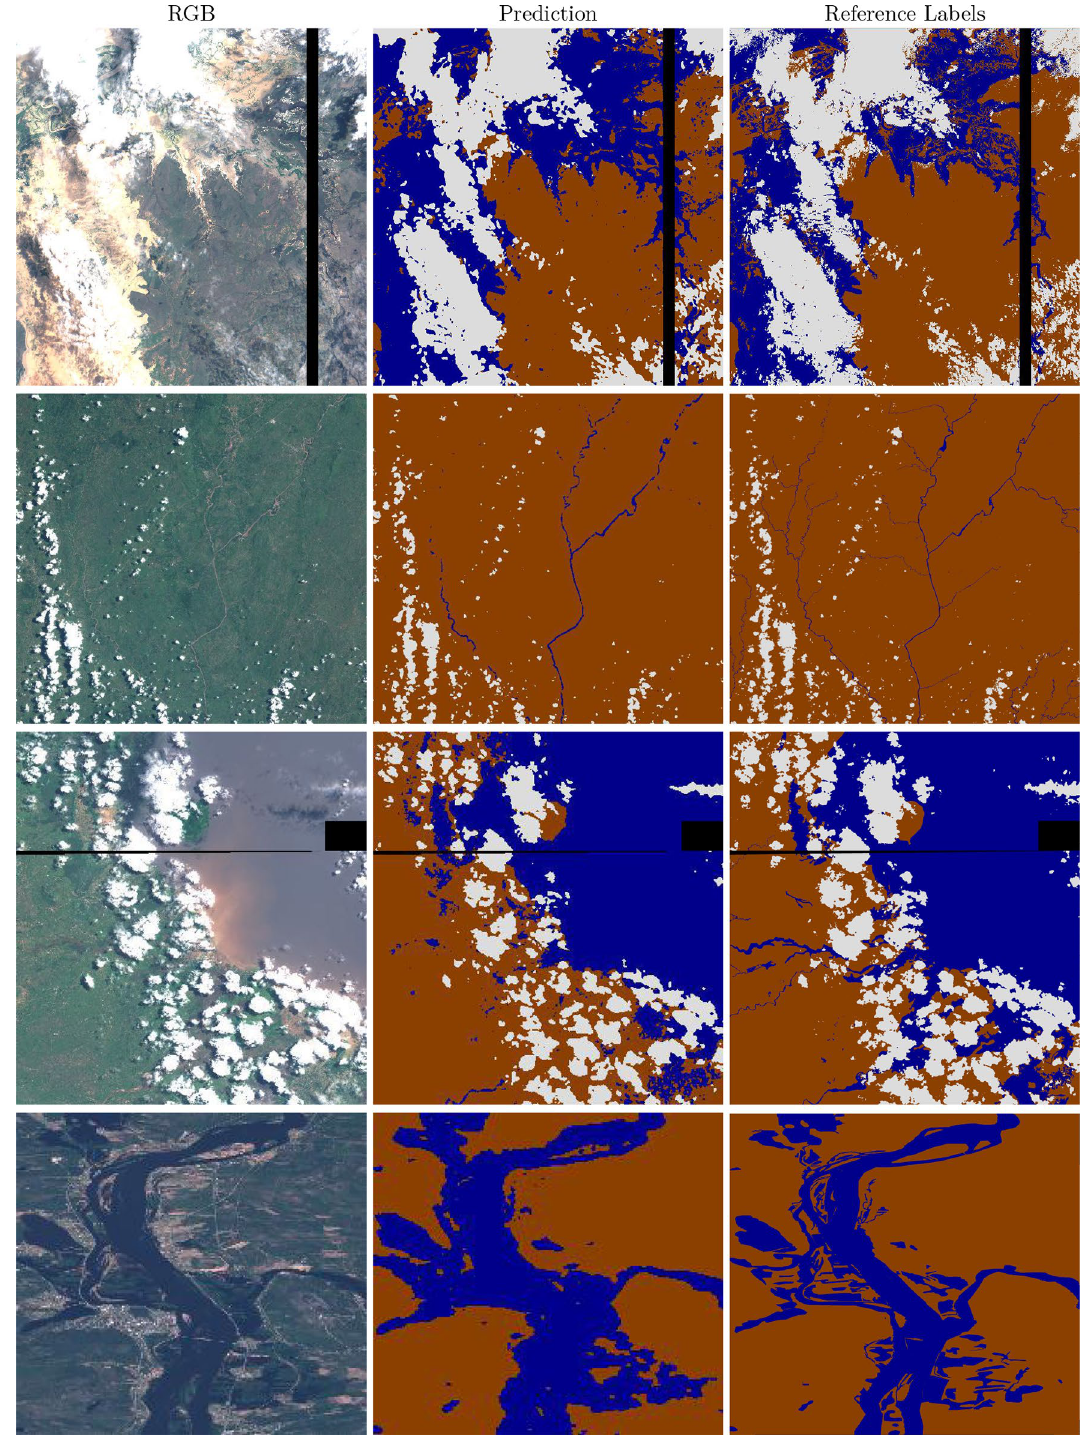
Figure 9. Segmentation results of degraded models (SCNN 80 m) run on Myriad 2 device. Sentinel 2 imagery and Copernicus EMS mapping products are provided as public domain. Base images and reference labels are included in the WorldFloods database and code for plotting these images may be found in our repository 6 . Colours are as follows: brown/land, blue/water,